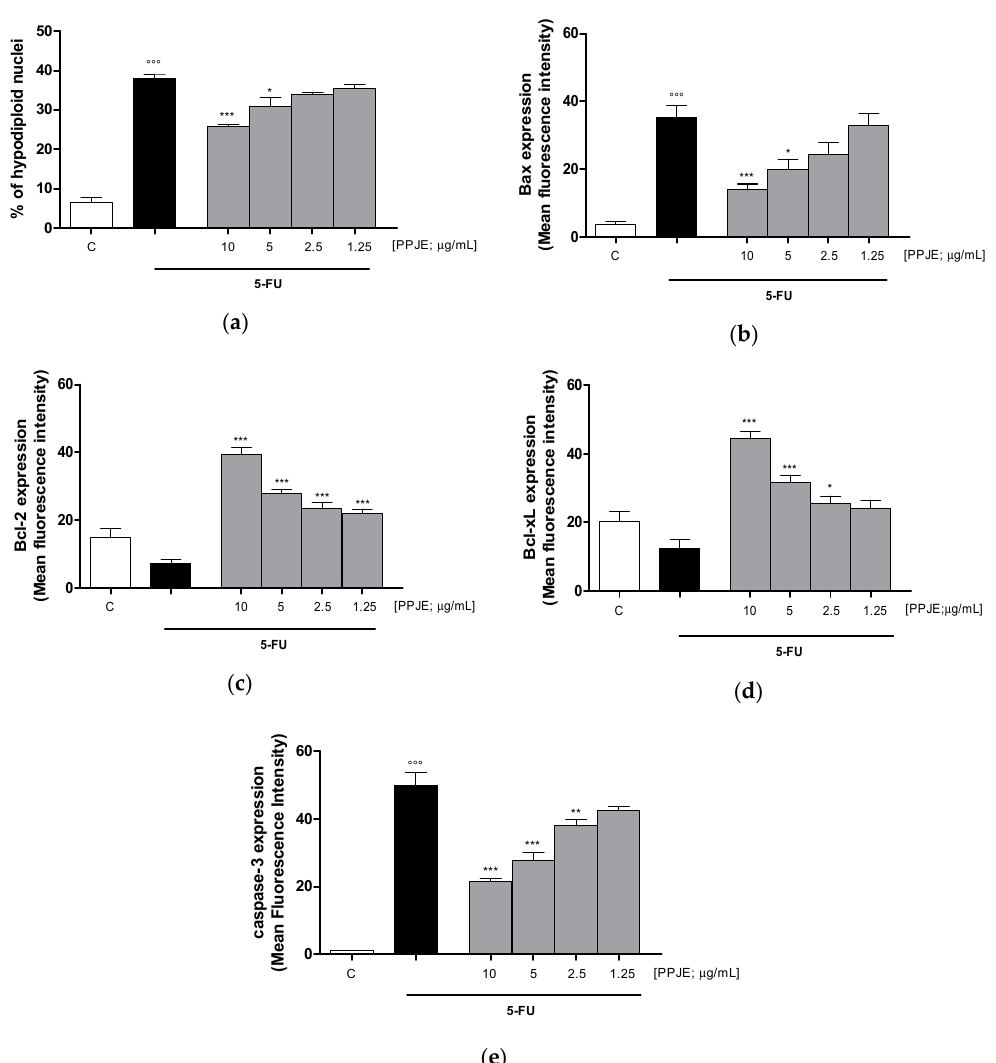
Figure 6. Effect of PPJE extract (10–1.25 μ g/mL) on 5-FU-treated IEC-6in reducing apoptosis ( a ), detected by propidium iodide (PI) assay, on Bax ( b ), Bcl-2 ( c ), Bcl-xL ( d ) and caspase-3 ( e ) expression, detected by flow cytometry. Data are expressed as % of hypodiploid nuclei or mean fluorescence intensity. C denotes control group. ***, ** and * denote respectively p < 0.001, p < 0.01 and p < 0.05 vs. 5-FU; ◦◦◦ denotes p < 0.001 vs. C.